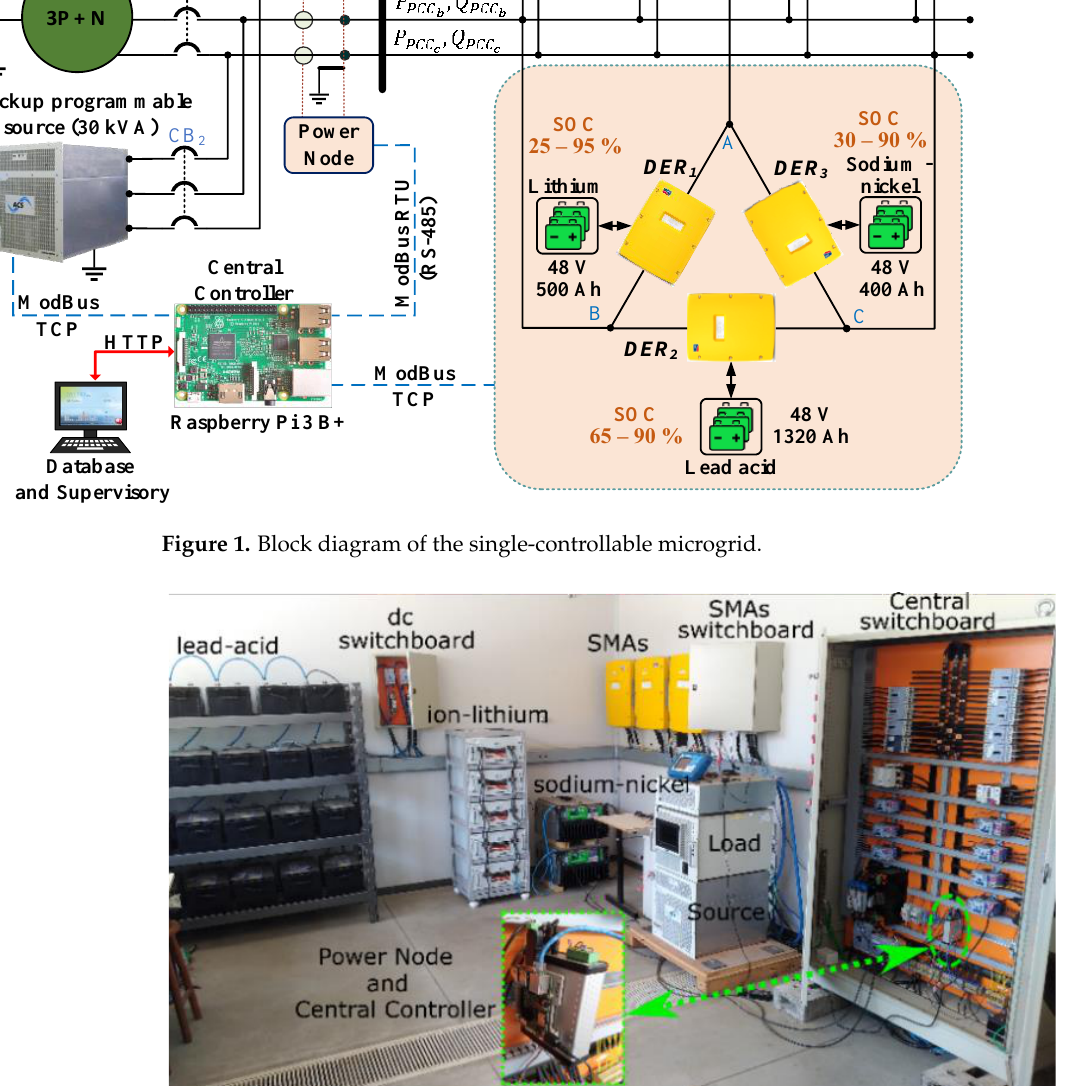
Figure 2. Actual installation of the single-controllable microgrid at UFMG, Brazil.